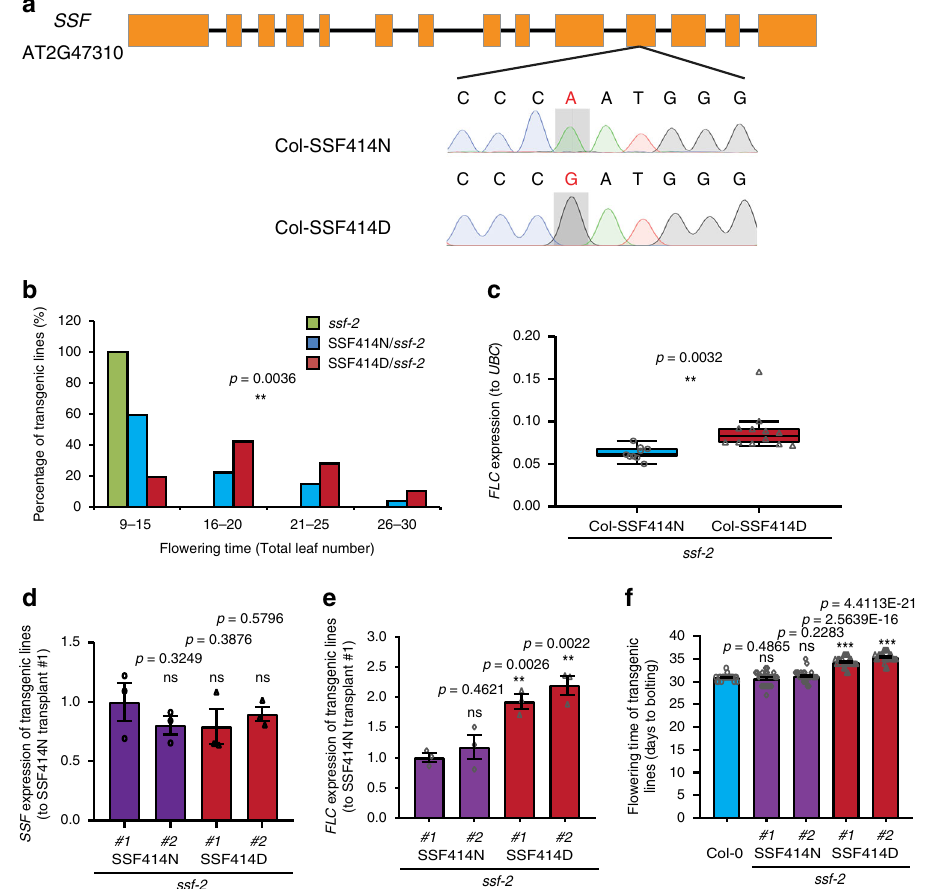
Fig. 3 The SSF-N414D polymorphism affects fl owering time and FLC expression. a Schematic illustration of SSF gene structure and the sequencing results of N414D mutagenesis. Boxes represent exons, and horizontal lines indicate introns. The polymorphisms of A/G nucleotides are shown in red. b Flowering time comparison of Col-SSF414N/ ssf-2 and Col-SSF414D/ ssf-2 transgenic plants. Twenty-three and 54 independent T2 transgenic lines were scored, with eight individuals from each line included. The number for ssf-2 was 20. c Comparison of FLC expression from the two transgenic plant materials containing either Col-SF414N/ ssf-2 (number of pools = 9) or Col-SSF414D/ ssf-2 (number of pools = 12). Fifty independent T2 transgenic lines from each construct were mixed to generate each sample pool. The difference in FLC expression between the two types of transgenic plants was signi fi cant. The UBC gene was used as an internal control for the RT-qPCR assays. Box plot: lower vertical bar = sample minimum, lower box = lower quartile, middle line = median, upper box = upper quartile, upper vertical bar = sample maximum, single points = outliers. d – f Two representative independent transgenic lines of Col-SSF414N and 414D with similar transgene expression ( d ) show distinct FLC expression levels ( e ) and fl owering times ( f ) ( n = 24). Data are presented as mean ± SEM. Asterisks indicate signi fi cant differences (** p < 0.01; *** p < 0.001, ns, not signi fi cant; two-tailed unpaired t test). Source data underlying Fig. 3b – f are provided as a Source data fi